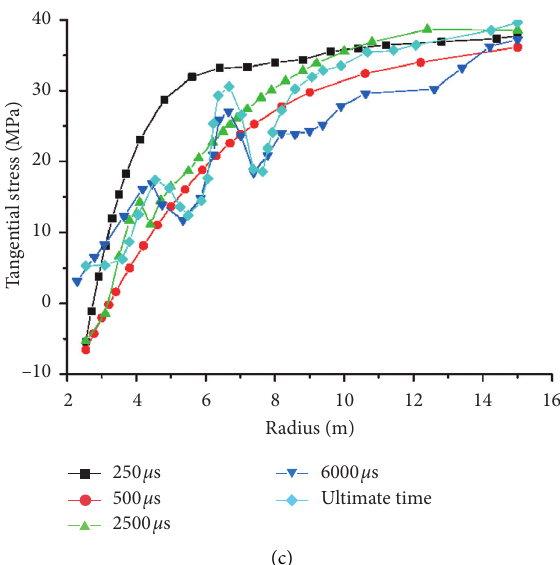
Figure 15: The displacement and stress changes of tunnel surrounding rock in different times. (a) Radial displacement. (b) Radial stress. (c) Tangential stress.